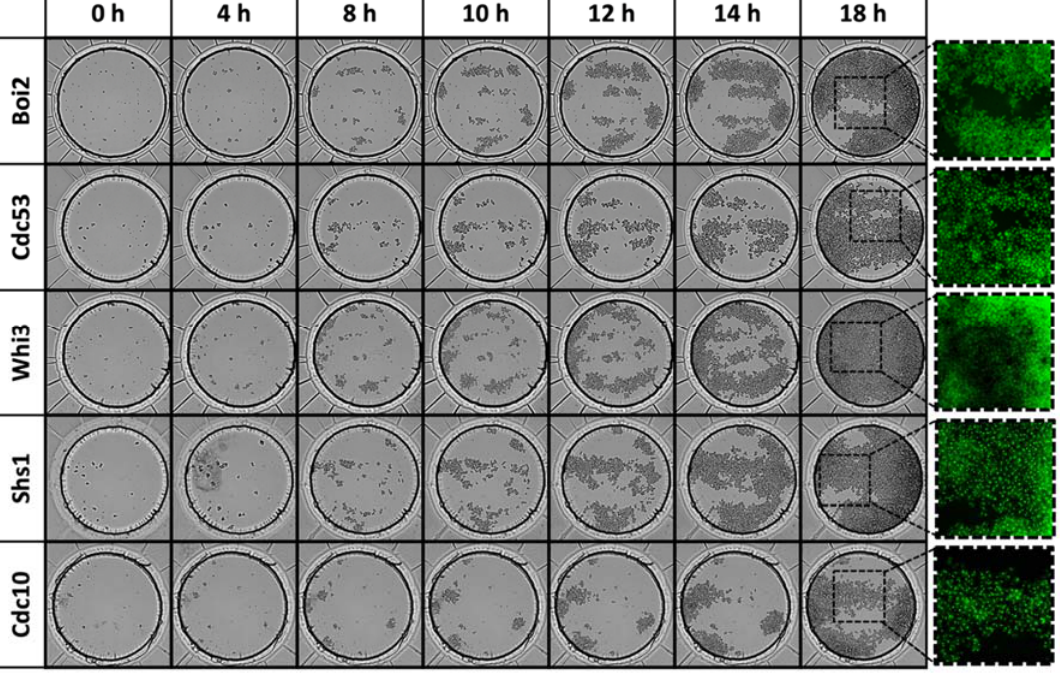
Figure 6. Yeast growth in some selected wells (see Figure S3 for the full overview).